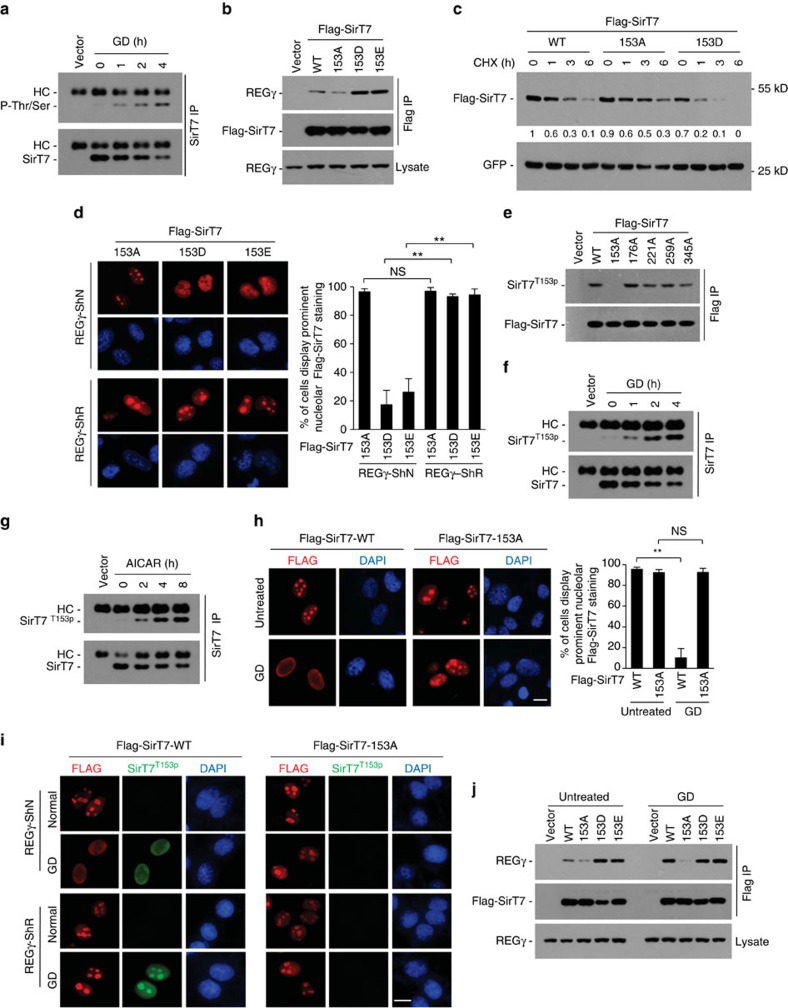
REGγ regulates SirT7 under starvation in a phosphorylation-dependent manner.(a) Cell lysates from GD (1–4 h)-treated 293 T cells were immunoprecipitated with SirT7 followed by western blotting using anti-phospho-Ser/Thr antibody (P-Thr/Ser). (b) 293 T cells transfected with indicated Flag-SirT7 T153 mutants were immunoprecipitated with FLAG-M2 beads followed by REGγ western blotting. (c) 293 T cells transfected with indicated Flag-SirT7 plasmids were treated with cycloheximide (CHX, 50 μg ml−1) and analysed for SirT7 stability by anti-FLAG western blot. Relative SirT7 band intensities were quantified through densitometry and presented. (d) REGγ-ShN and -ShR HeLa cells transfected with indicated Flag-SirT7 mutants were immunostained with anti-Flag antibody (red) and visualized by microscopy (scale bar, 10 μm). Graph shows the percentage of cells displaying prominent nucleolar SirT7 staining. Data represent mean±s.d., n=3, >100 cells were counted per replicate. NS=not significant, **P<0.01, Students t-test. (e) Characterization of SirT7 T153 phosphorylation antibody (SirT7 T153p). Cell lysates from 293 T cells transfected with wild-type or mutant forms of Flag-SirT7 were immunoprecipated with FLAG-M2 beads followed by western blot using antibody against SirT7 T153p or Flag. (f,g) Cell lysates from GD (f) or AICAR (0.5 mM) (g) treated 293 T cells were immunoprecipitated with anti-SirT7 antibody followed by immunoblot with anti-SirT7 T153p or anti-SirT7 antibodies. HC, heavy chain. (h) Flag-SirT7-WT or -T153A mutant transfected HeLa cells were treated with or without GD (12 h) followed by immunostaining with anti-Flag antibody (red). Scale bar, 10 μm. Graph shows the percentage of cells displaying prominent nucleolar SirT7 staining. Data represent mean±s.d., n=3, >100 cells were counted per replicate. NS=not significant, **P<0.01, Students t-test. (i) Stable REGγ-ShN and REGγ-ShR HeLa cells transfected with Flag-SirT7-WT or -153A mutant were treated with or without GD (12 h), then immunostained with anti-FLAG (red) and anti-SirT7 T153p (green) antibodies and visualized by microscopy (scale bar, 10 μm). Nuclei were stained with DAPI. The SirT7-T153A mutant was used to evaluate the specificity of the SirT7 T153p antibody. (j) 293T cells transfected with indicated Flag-SirT7 plasmids were treated with or without GD (1 h). Cell lysates were immunoprecipitated with FLAG-M2 beads and probed with anti-REGγ or anti-Flag antibodies. See also Supplementary Fig. 4.